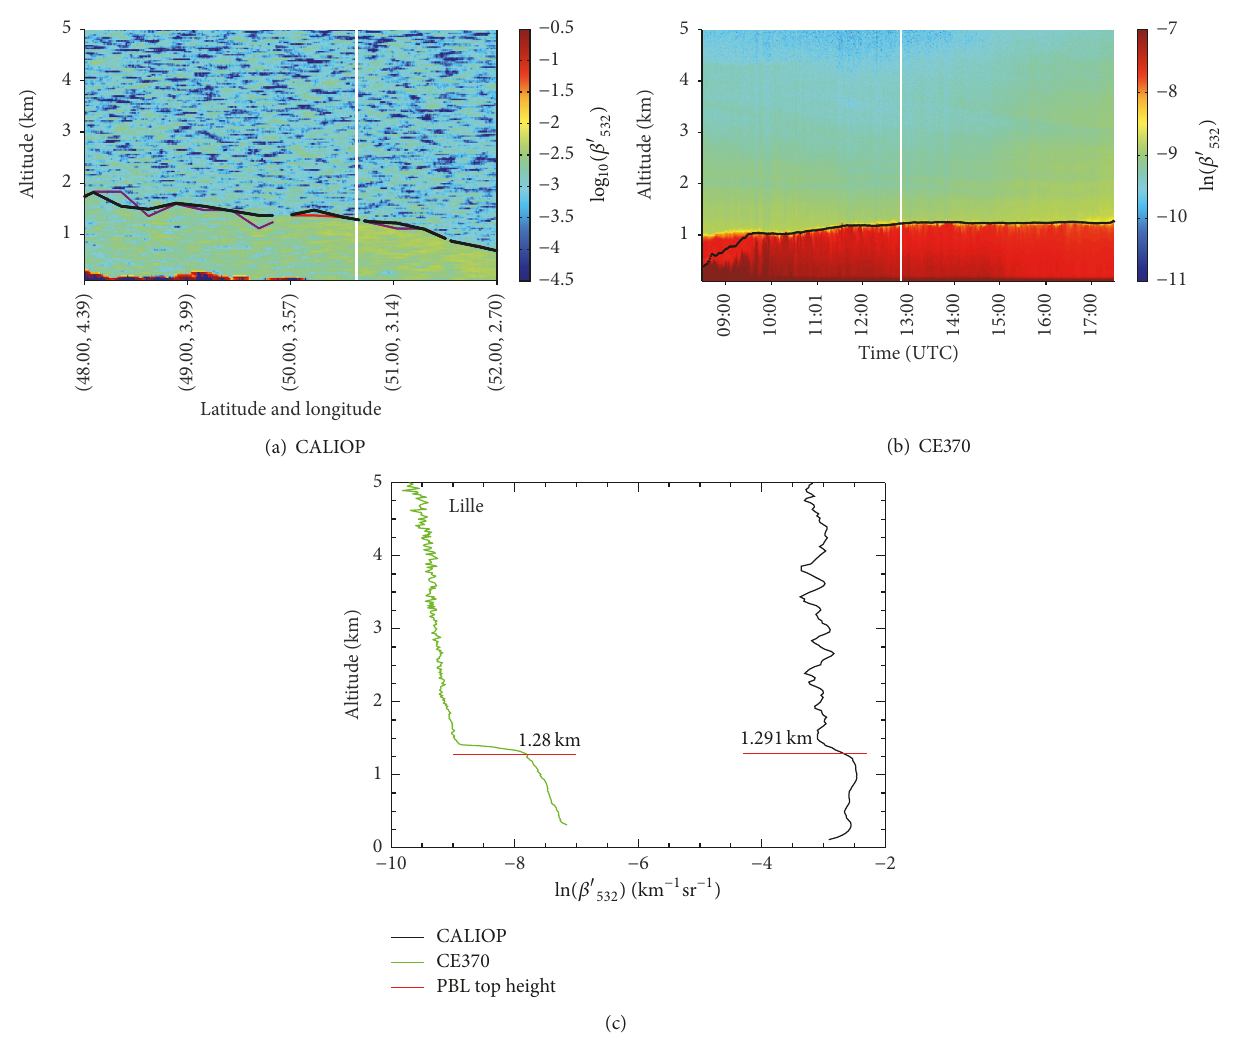
Figure 7: Similar to Figure 6, but for a polluted sky